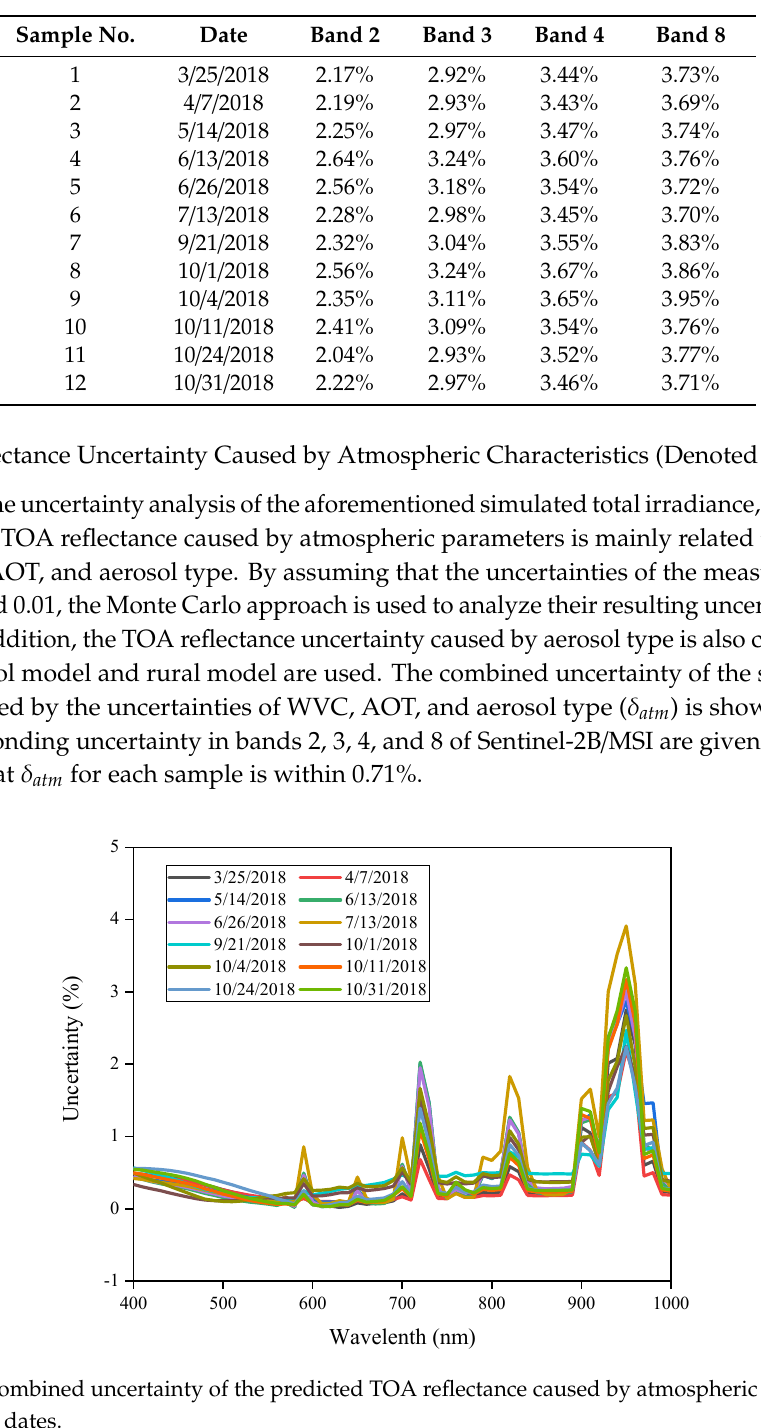
Table 4. The uncertainty results of the predicted TOA reflectance caused by surface characteristics in bands 2, 3, 4, and 8 of Sentinel-2B / MSI.